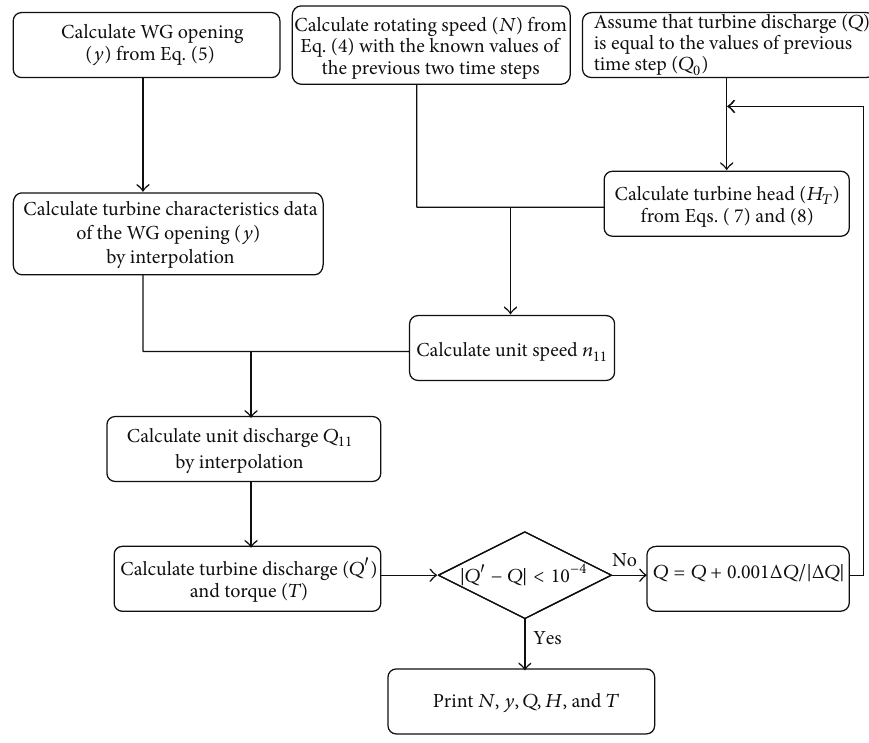
Figure 1: Flowchart of boundary condition for a turbine.